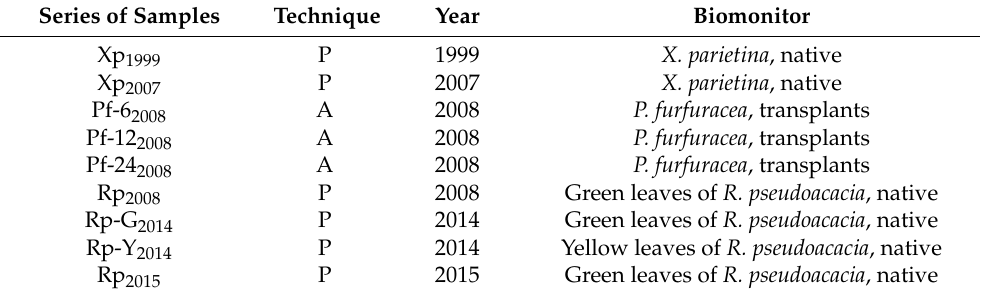
Table 1. Notation used to name the nine sample series analyzed in this work. The notation used refers to the following: (i) biomonitor species (Xp: X. parietina ; Pf: P. furfuracea ; Rp: R. pseudoacacia